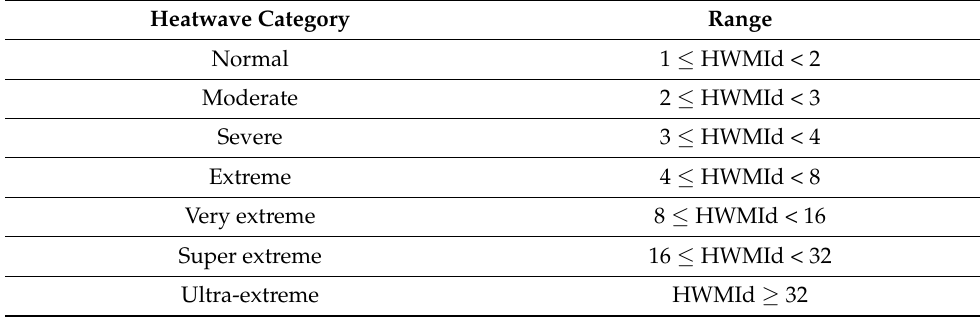
Table 1. Classification of Heatwave Magnitude Index daily